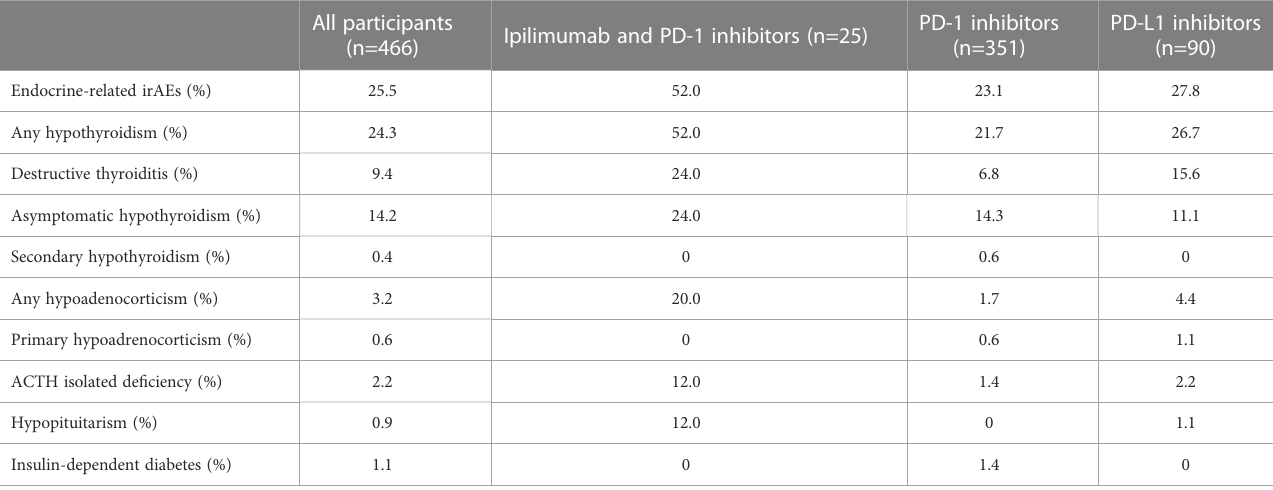
TABLE 2 Prevalence of endocrine-related immune-related adverse events after treatment with various immune check point inhibitors.